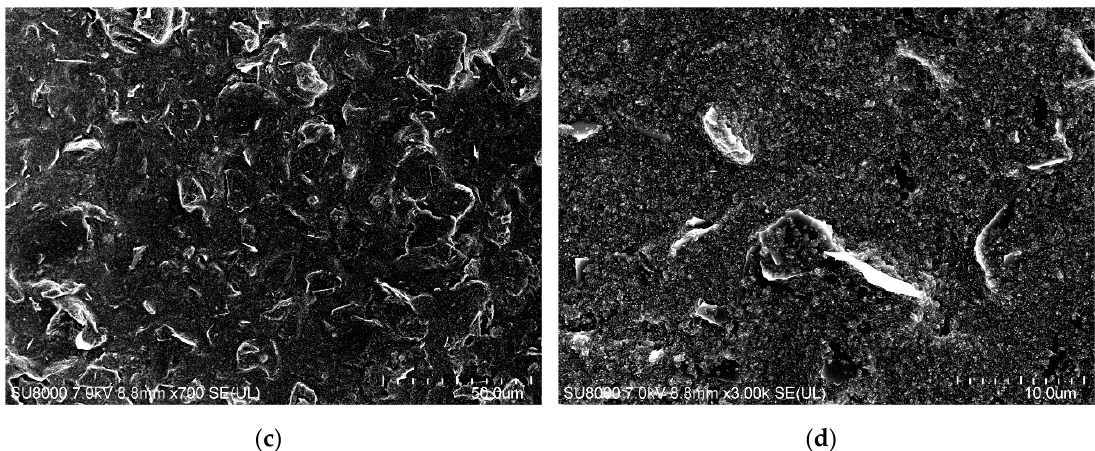
Figure 12. Scanning electron microscope images of the carbon paste films: ( a ) dried in an air convection oven at 120 °C for 30 min, with 700 times magnification; ( b ) dried in an air convection oven at 120 °C for 30 min, with 3k times magnification; ( c ) dried at the room temperature for 24 h, with 700 times magnification; and ( d ) dried at the room temperature for 24 h, with 3k times magnification. The cavity is highlighted by the red dashed circle.